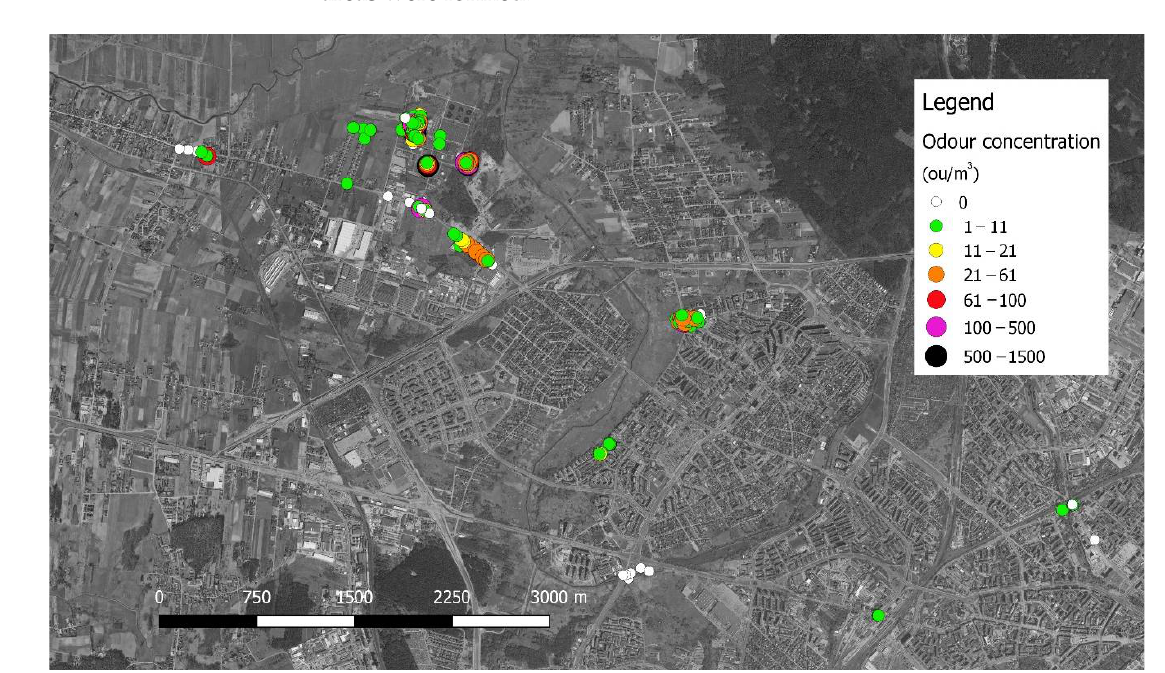
Figure 3. c od in the atmosphere of the north-western part of Białystok (at a height of 1.8 m).